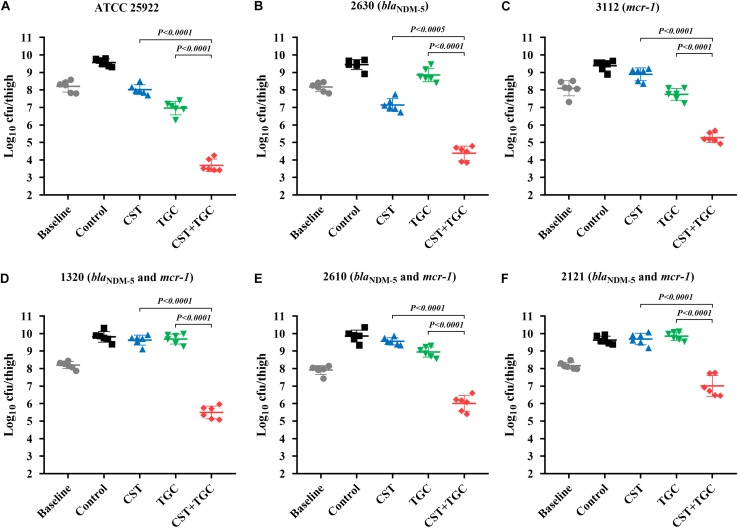
Efficacy of colistin and tigecycline mono- and combination therapies at 24 h against E. coli ATCC 25922 (A), 2630 (B), 3112 (C) and strains harboring blaNDM–5 and mcr-1
(D–F) in the murine thigh infection model with a high initial burden of 108 cfu/thigh. Colistin (7.5 mg/kg i.p. bid) and tigecycline (5 mg/kg s.c. bid) and the combination were administrated at 2 h post-infection. Horizontal lines represent the mean and standard deviation of bacterial densities for each group (n = 6). Colistin and tigecycline combination therapy resulted in a >2.5 log10cfu/thigh reduction relative to each monotherapy (P < 0.0005, Mann-Whitney U-test).